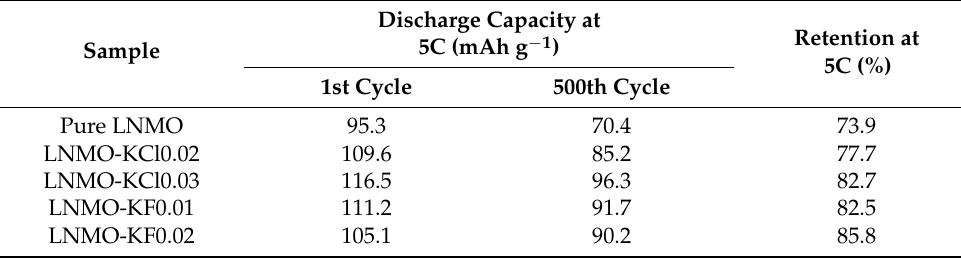
Figure 9. Cycling performances of all samples at 5C for 500 cycles at 3.5–5.0 V. Table 5. Discharge capacity retention of all samples at 5C after 500 cycles at 25 °C.